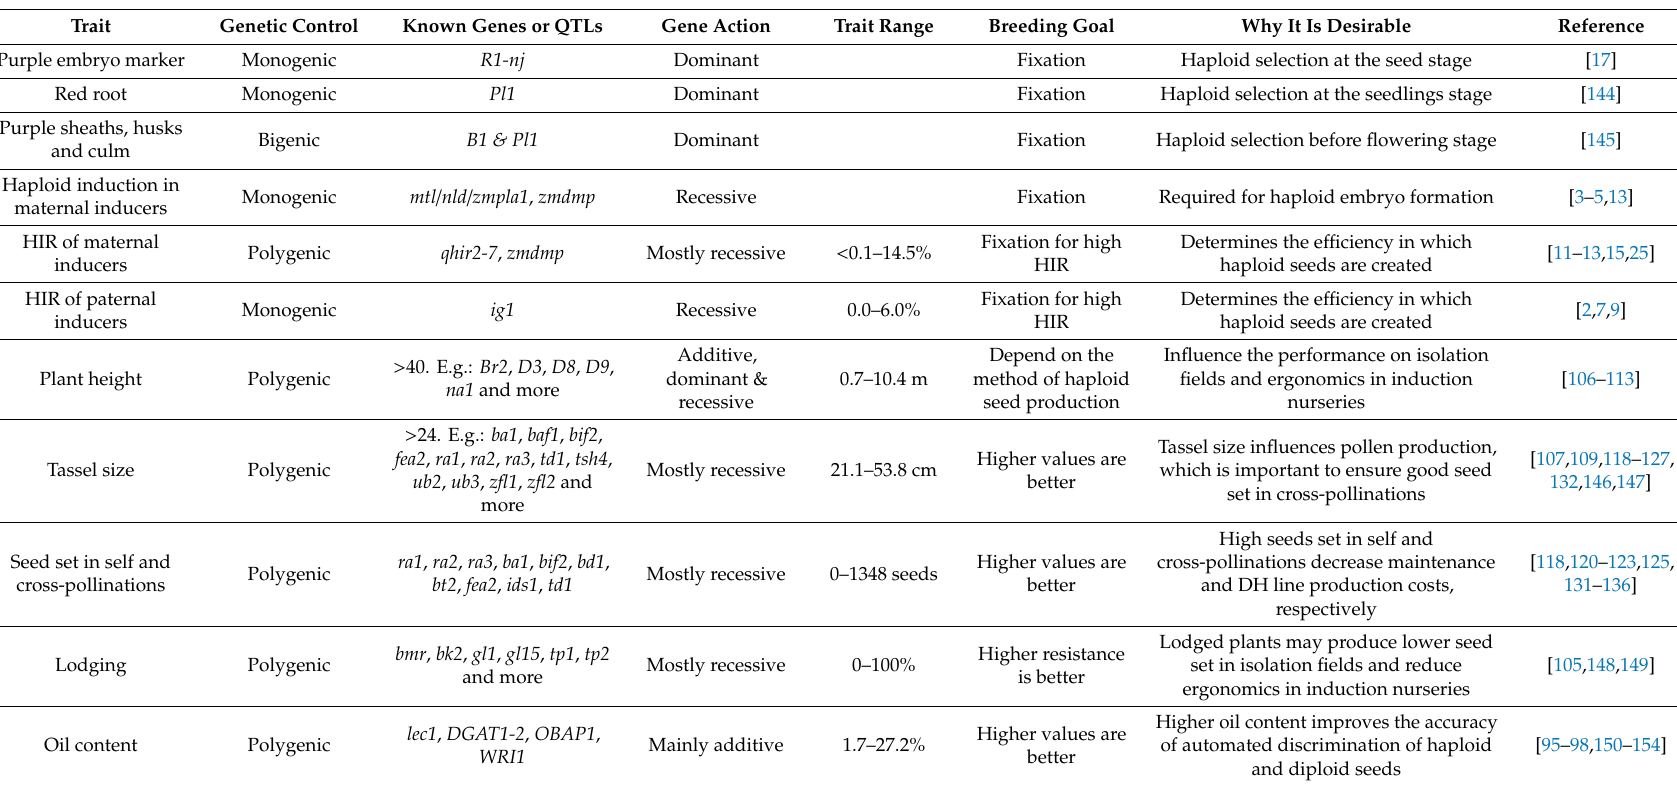
Table 1. List of di ff erent traits important to haploid inducers, along with their genetic control, known genes or QTL, mode of gene action, observed trait range, breeding goal and brief explanation of their